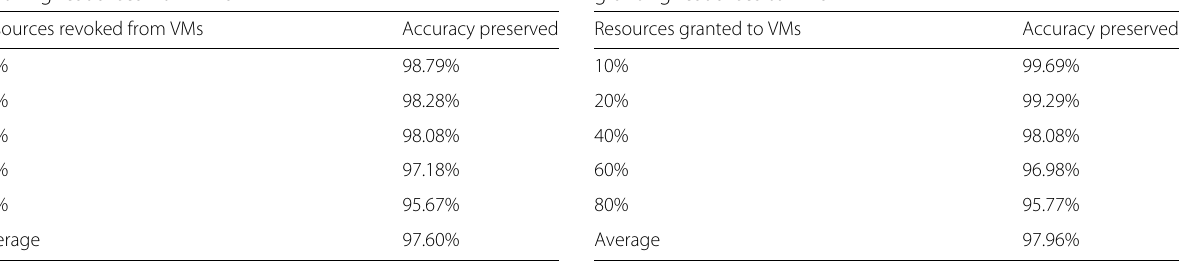
traditional SVM and Decision-Tree detection [52] tech- niques. The traditional-SVM uses the SVM classifier directly, without applying any filtering strategy that can cope with the effect of the resources adjustment